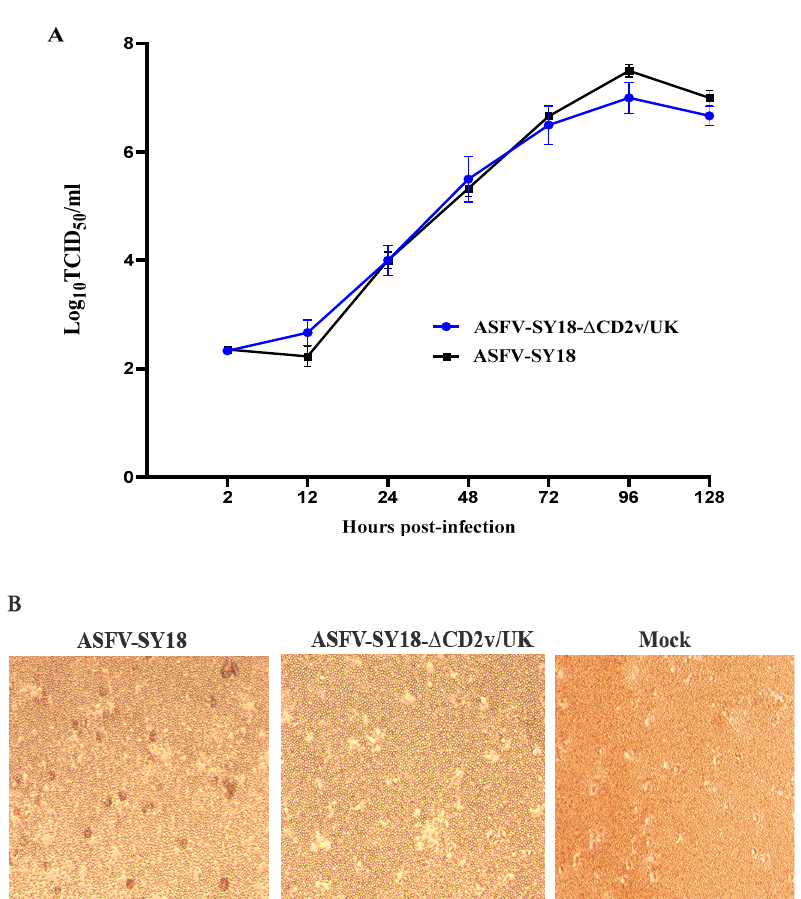
Figure 2. In vitro replication and hemadsorption of ASFV-SY18- ∆ CD2v / UK compared to the wild-type ASFV. ( A ) The in vitro replication kinetics of ASFV-SY18- ∆ CD2v / UK. The y -axis represents the virus titers recovered at di ff erent time points following infection to AM in TCID 50 / mL on between 0 and 120 h post-infection. The data represent the means from two independent experiments and error bars represent standard deviations of the means. ( B ) The hemadsorbing activity of ASFV-SY18- ∆ CD2v / UK and wild-type ASFV in infected cells. Monolayers of AM infected with ASFV-SY18- ∆ CD2v / UK or wild-type ASFV or non-infected cells (Mock) were shown.